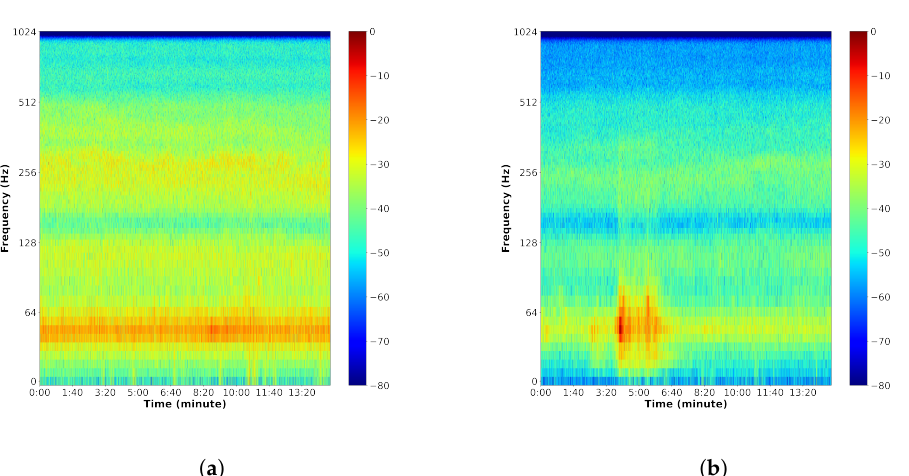
Figure 6. Spectrograms of cases where urban noises (e.g., train rail squealing sounds) are ( a ) not present and ( b ) present.